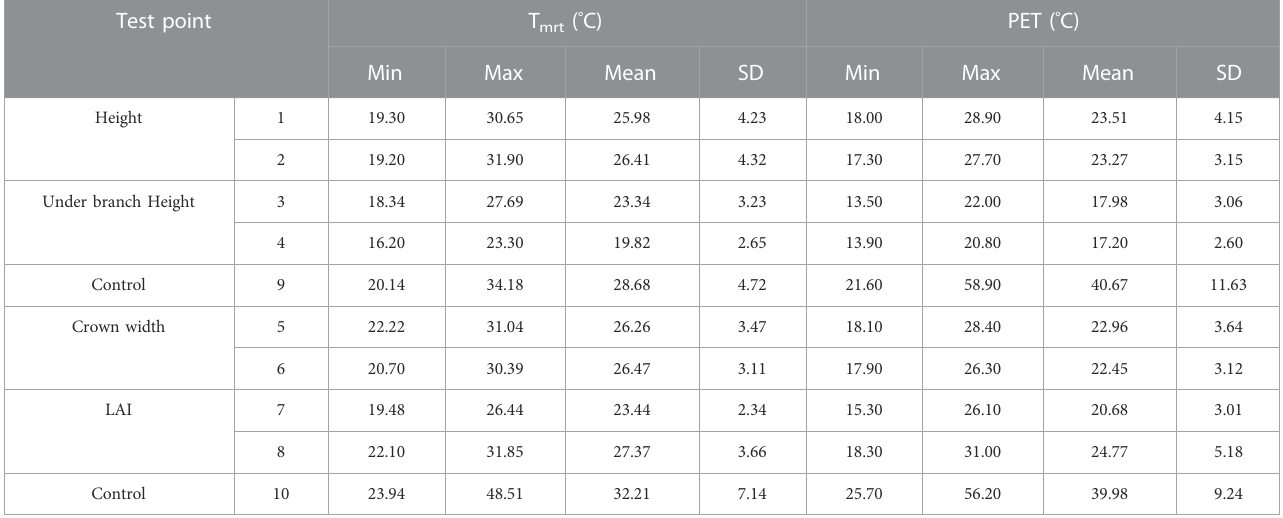
TABLE 4 Description of T mrt and PET.